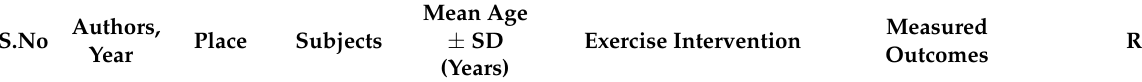
Table 4. Effect of exercise on subjects with sarcopenia and neurological diseases. Table 1. Effect of exercise on subjects with cancer and baseline measurement of